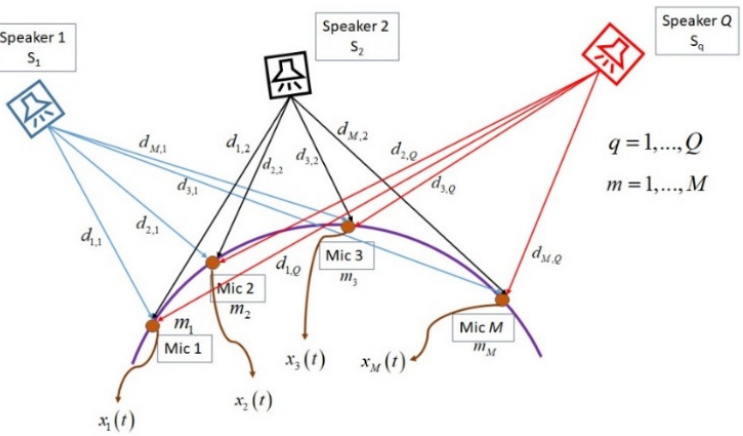
Figure 1. The relation between sound signals and microphones in near-field assumption for multiple speakers.